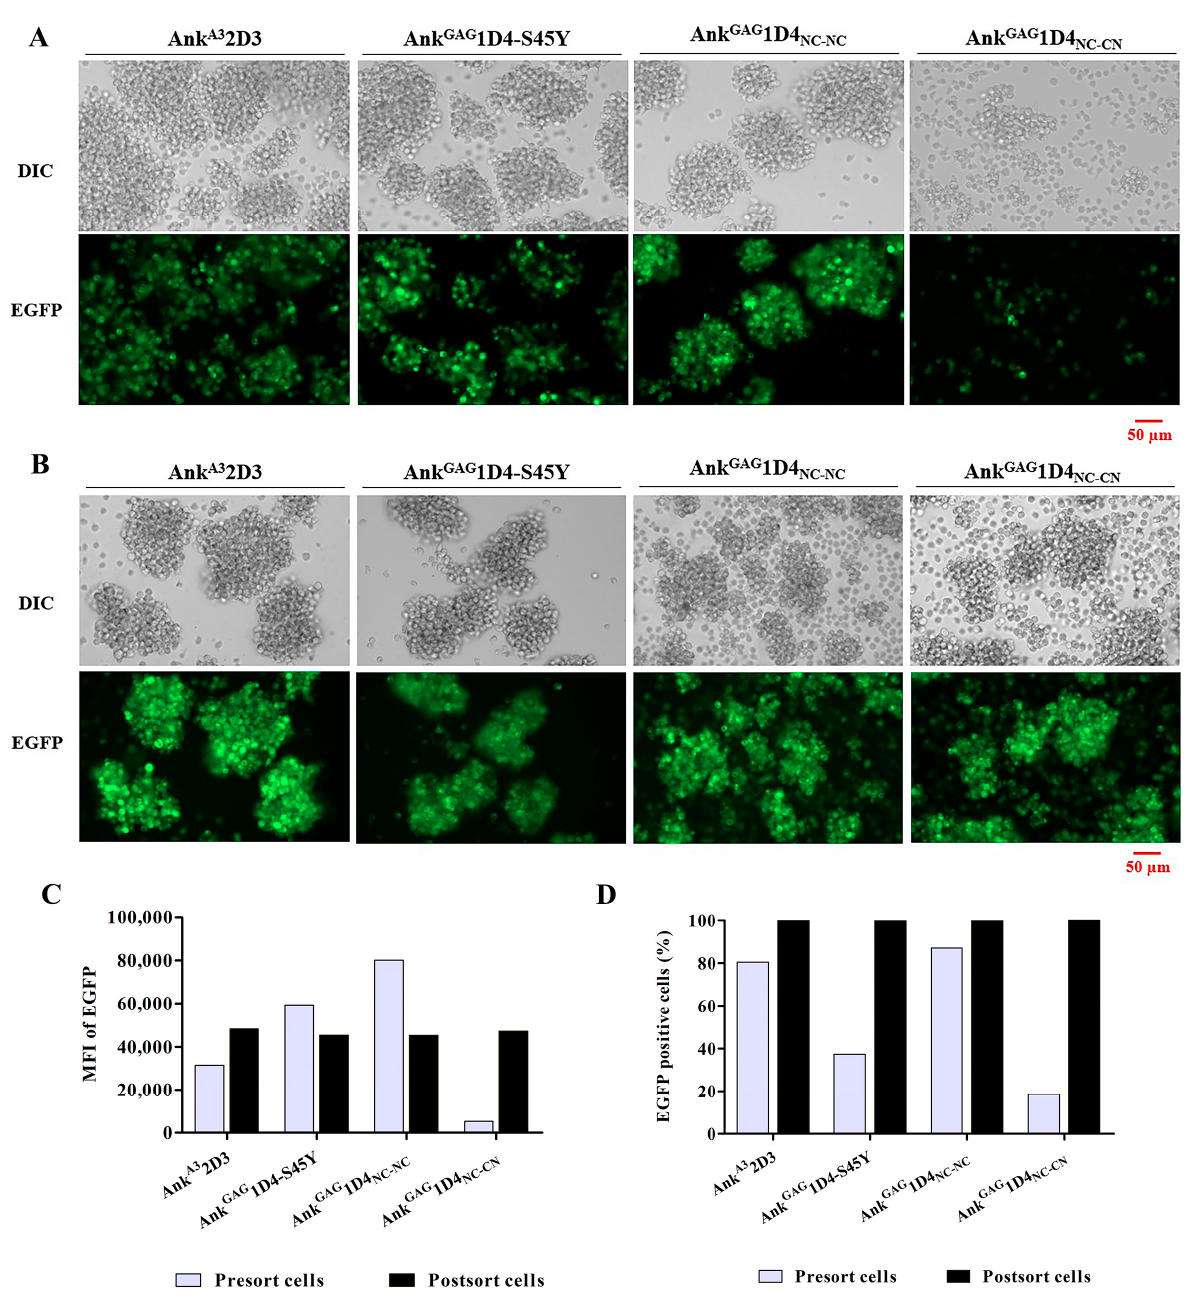
Figure 5. Expression of ankyrin-EGFP in transduced SupT1 cells: ( A ) At 48 h post-transduction, SupT1 cells showed EGFP expression under inverted fluorescence microscopy. These cells were sorted for an equivalent in ankyrin expression; ( B ) Post-sort cells showed EGFP expression under inverted fluorescence microscopy. Cell imaging was performed at 20× magnificent using Zeiss Colibri 7. Scale bar: 50 µm.; ( C ) The MFI of EGFP; and ( D ) percentage of EGFP positive cells of transduced SupT1 cells was determined using flow cytometry. Ank A3 2D3, Ank GAG 1D4-S45Y, Ank GAG 1D4 NC-NC and Ank GAG 1D4 NC-CN represent SupT1 cells expressing Myr (+) Ank A3 2D3-EGFP, Myr (+) Ank GAG 1D4- S45Y-EGFP, Myr (+) Ank GAG 1D4 NC-NC -EGFP, and Myr (+) Ank GAG 1D4 NC-CN -EGFP,